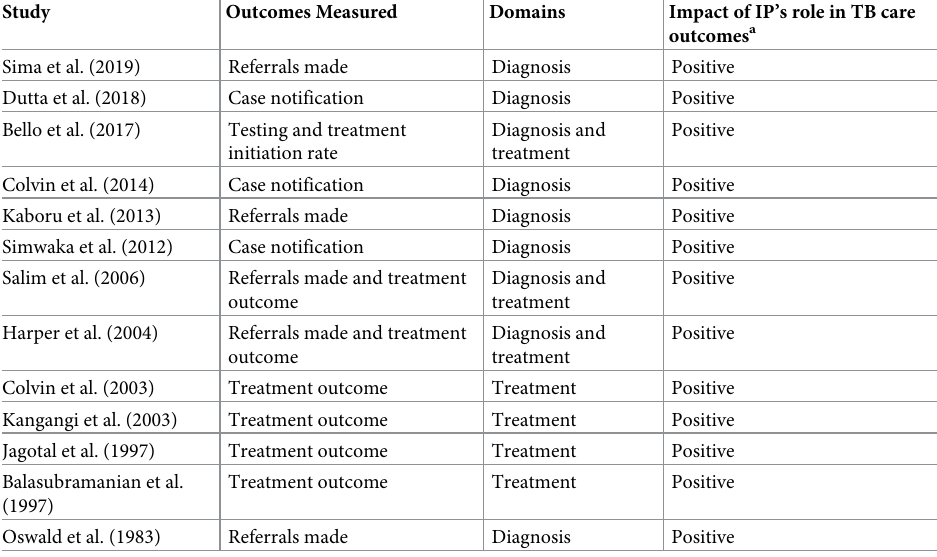
Table 3. Distribution of outcomes measured in included